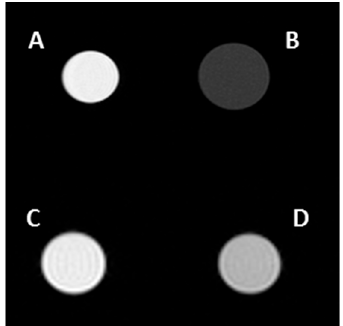
Figure 5. 7 T 1 H MRI images obtained in phantom experiments on solutions of nanoparticles NP-C6OF-PEG/C6OF-DO3AGd ( A ); NP-C6OF-PEG ( B ); NP-C8TEG/C8-DO3AGd-a ( C ); NP-C8TEG/C8-DO3AGd-b ( D ). All experiments were performed on 40 mg/mL solutions of the